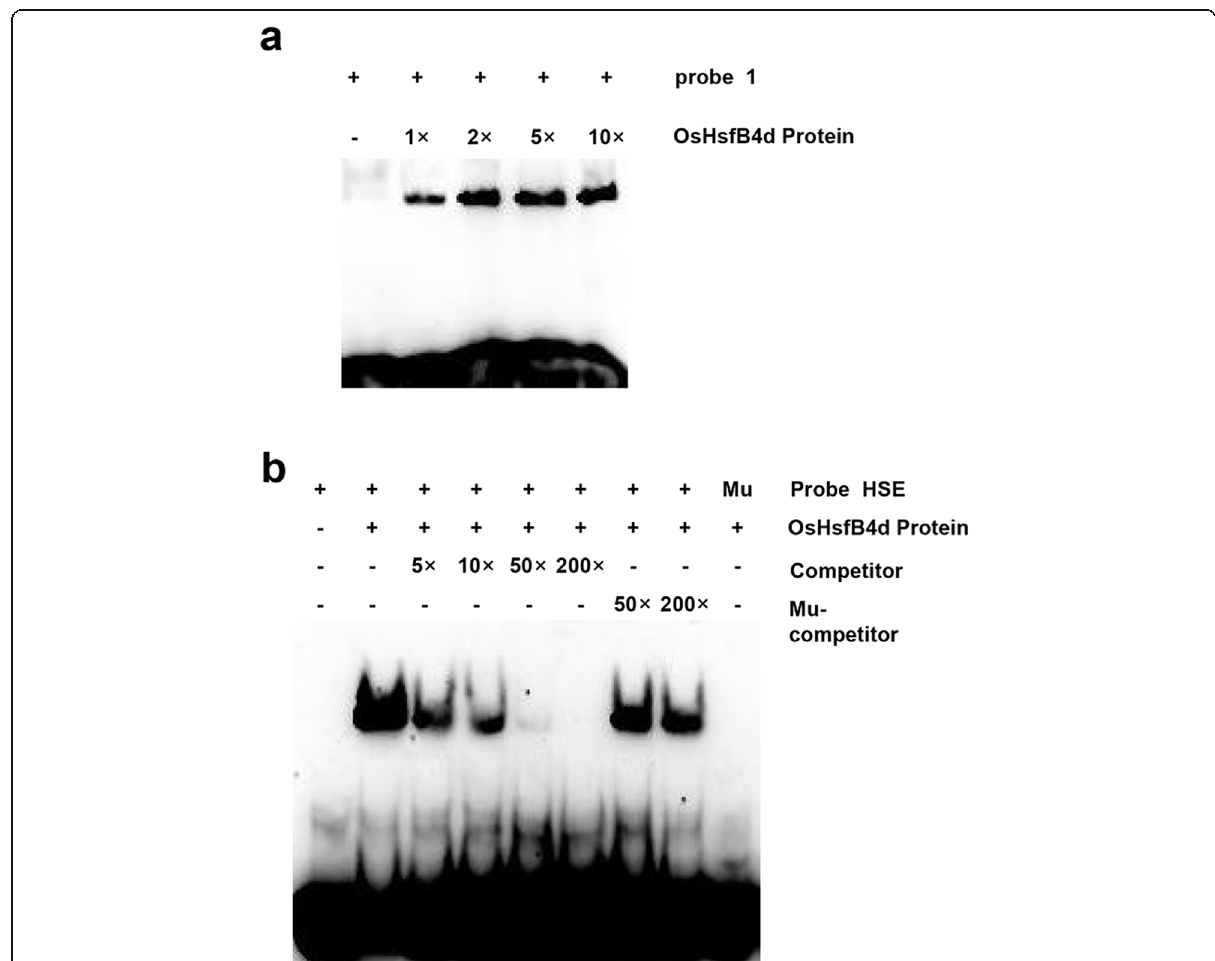
Fig. 7 OsHsfB4d binds to the perfect HSE motif with the OsHsp18.0-CI promoter. a EMSA using the probe 1 and different amount of recombinant His-tagged OsHsfB4d. 1× represents about 0.53 μ g of the purified OsHsfB4d. b OsHsfB4d bind to the perfect HSE cis -element. The OsHsfB4d protein was incubated with the labeled probe to serve as a positive control; mutated probes (Mu) were used as a negative control. 5-, 10-, 50- and 200-fold excesses of unlabeled probes were used for competition. 50- and 200-fold excesses of mutated probes were used for competition. Mutated probe in which the perfect HSE motif 5 ′ - GAAACTTC − 3 ′ was replaced with 5 ′ - CAAACAAT -3